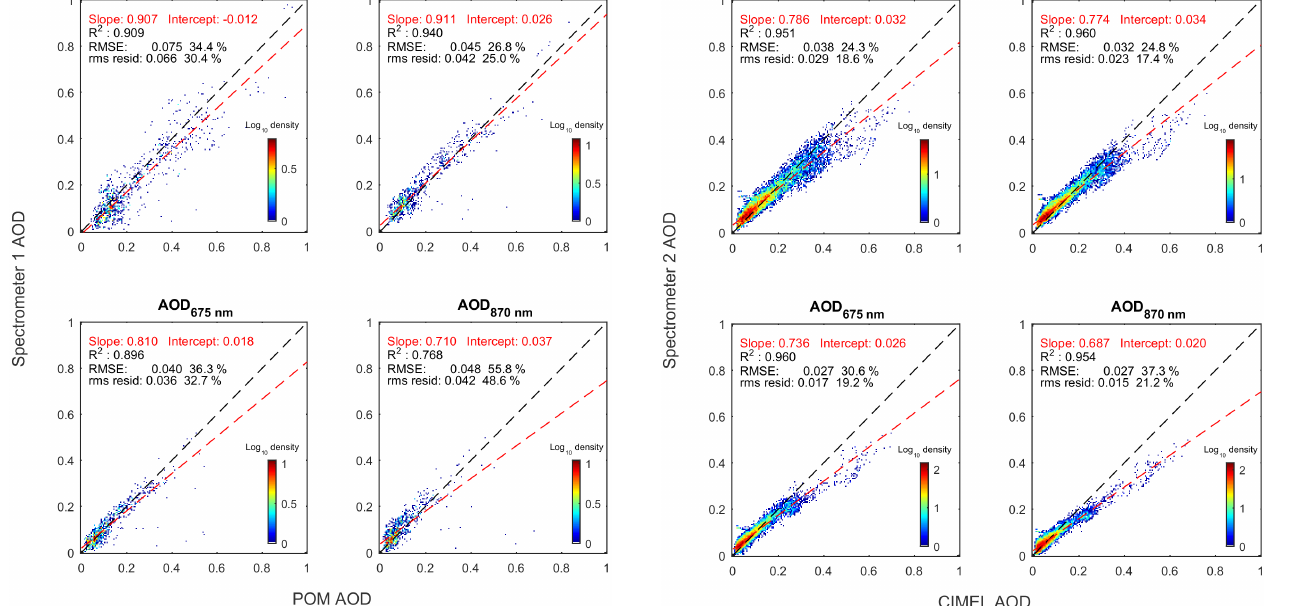
Figure 7. Spectrometer 2 (Zeiss) AOD results compared with CIMEL sun photometer at Burjassot, January 2015–July 2016. These are log density plots: red points represent around 100 data points, whereas the blue points only represent a single data point. No further corrections were applied.